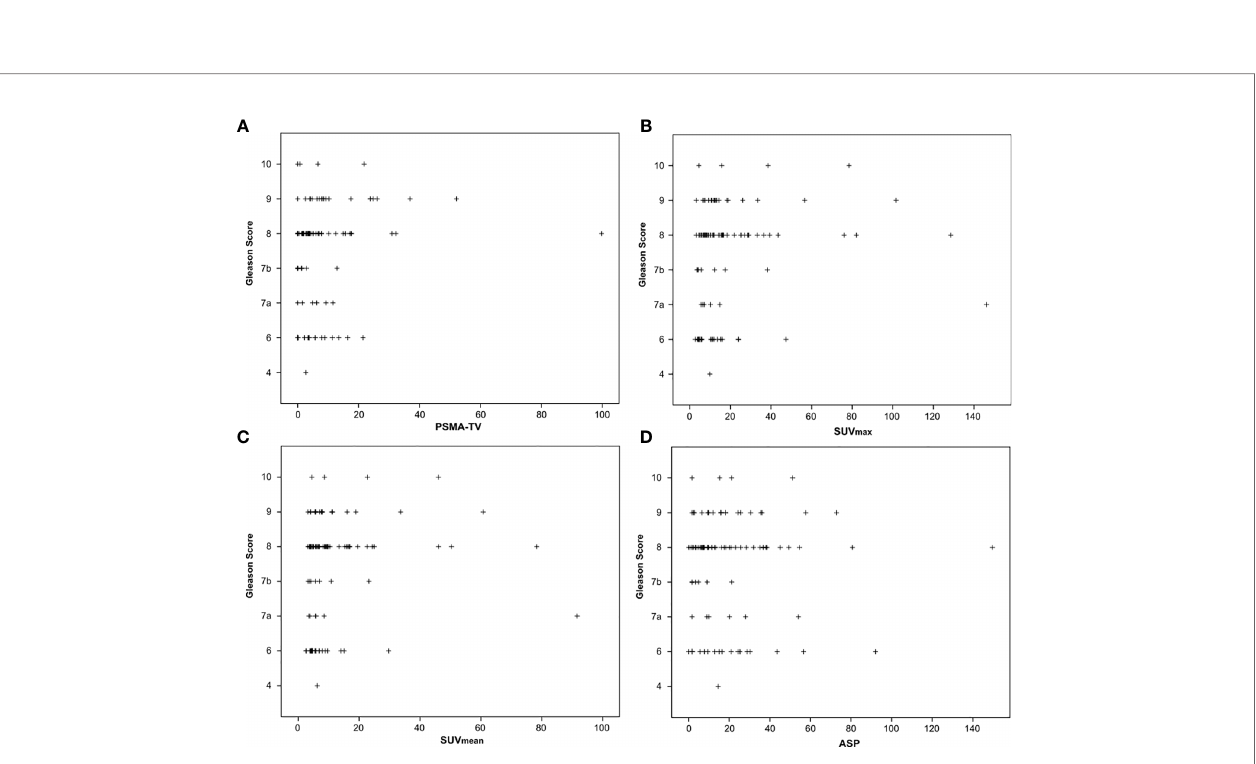
FIGURE 2 | Correlation between Gleason scores obtained by biopsy before imaging and quantitative PSMA-PET parameters. (A) PSMA-derived tumor volume (PSMA-TV), (B) Maximum standardized uptake value (SUVmax), (C) Mean standardized uptake value (SUVmean) and (D) Tumor asphericity